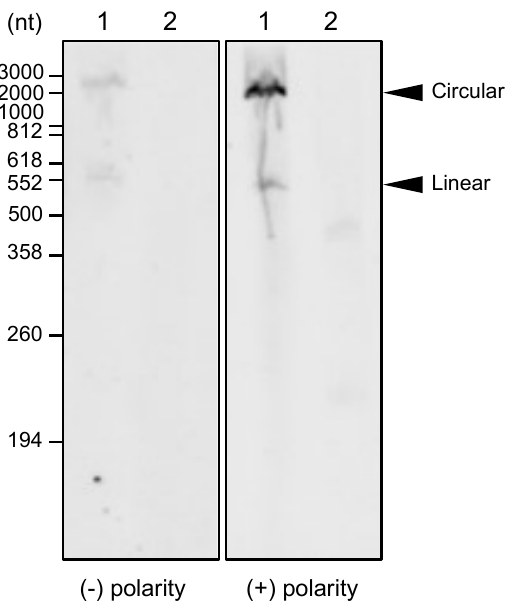
Figure 1. Detection of circular and linear forms of both polarity strands of CtaHVd-LR1 by northern blot hybridization assays. Lane 1, RNA preparation from citrus isolate 14A tested positive to CtaHVd-LR1 by HTS and RT-PCR; lane 2, RNA preparation from a sample of citrus isolate 14O tested negative to CtaHVd-LR1 by RT-PCR (negative control); size of RNA markers are indicated on the left. Identical aliquots of the same RNA preparations were loaded in parallel in the same gel; after nucleic acid transfer, the membrane was cut vertically, and each half membrane was hybridized with equalized DIG-probes to detect the (+) and the (−) polarity strand of CtaHVd-LR. Hybridization signals from both membranes were recorded simultaneously. The positions of circular and linear forms of CtaHVd-LR1 are indicated on the right. The (+) polarity was assigned, by convention, to the CtaHVd-LR1 polarity strand that accumulates at a higher level in vivo and generated a stronger hybridization signal (left panel).